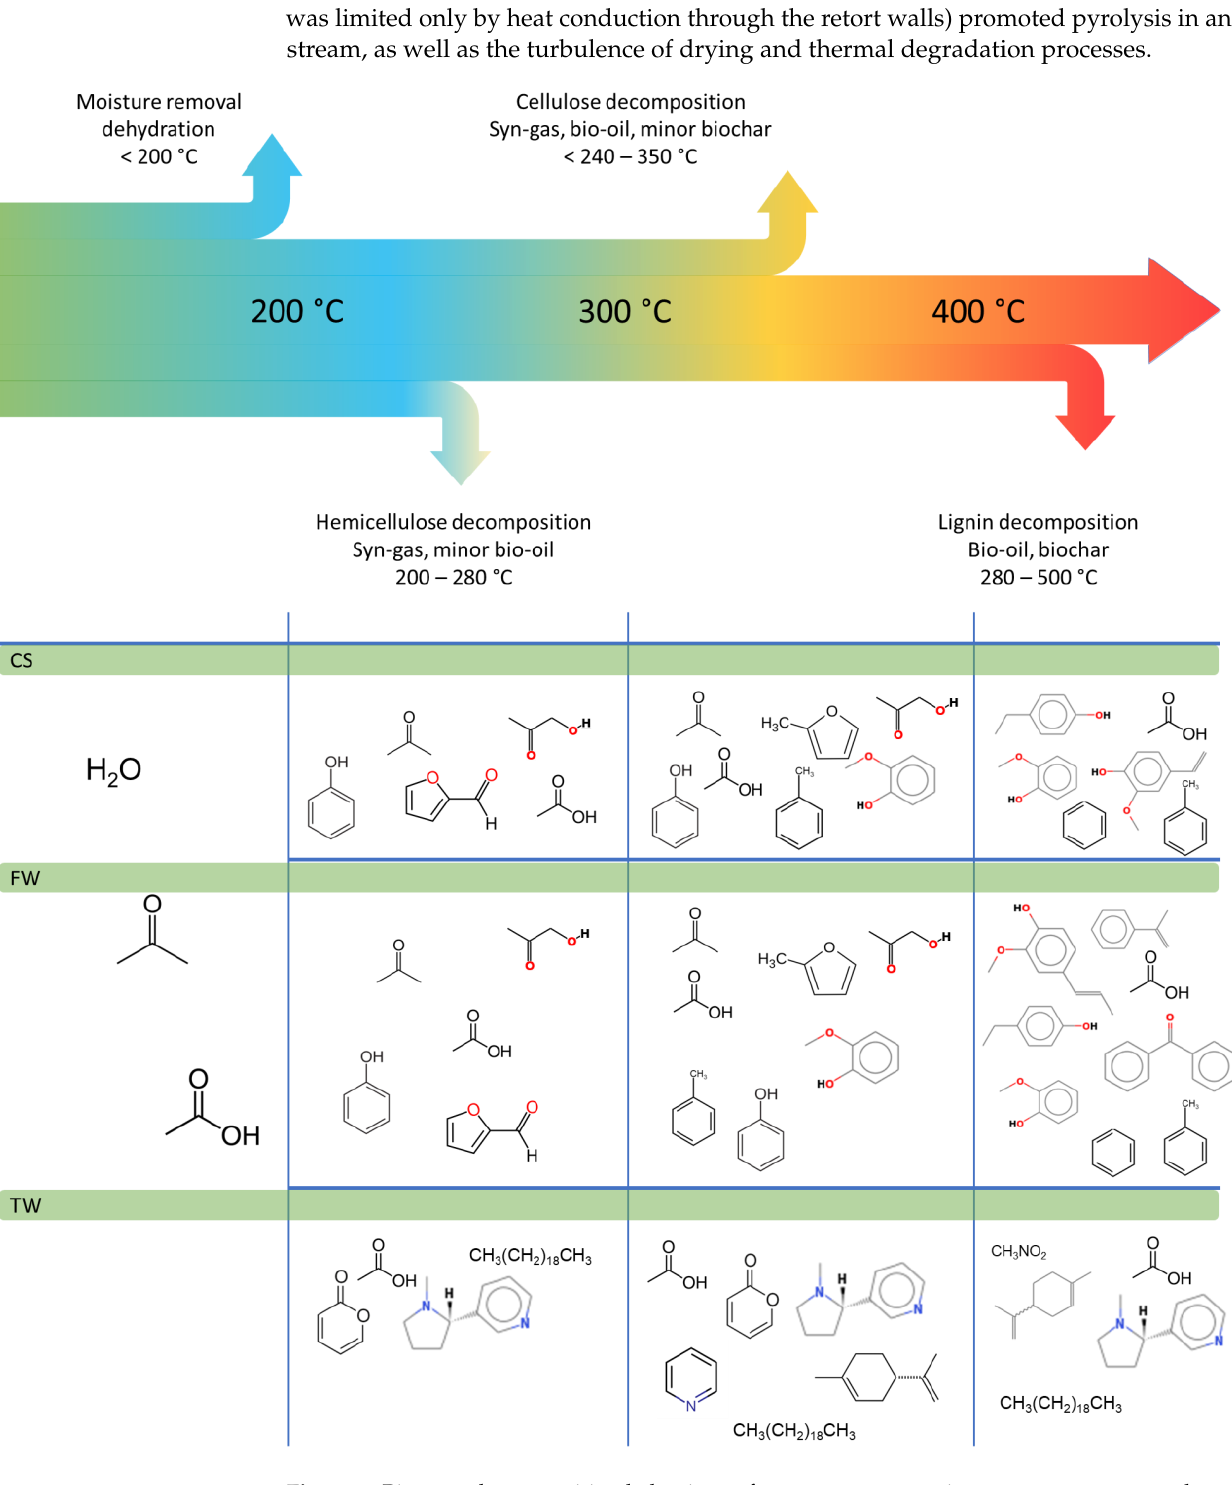
Figure 9. Biomass decomposition behaviour of components at various temperatures together with selected chemical compounds released during the different stages of pyrolysis.